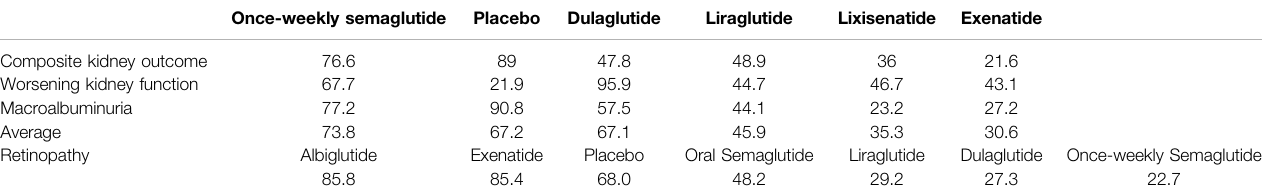
TABLE 5 | SUCRAs of treatments according to fi ve secondary outcomes. Once-weekly semaglutide Placebo Dulaglutide Composite kidney outcome